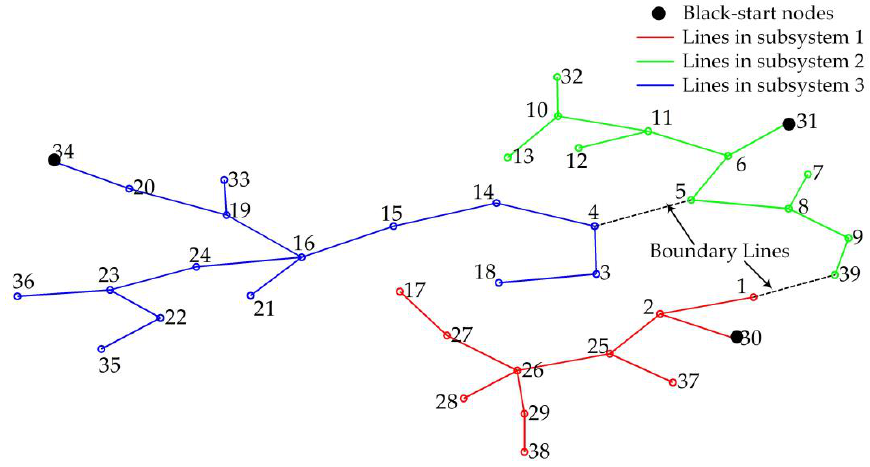
Table 2. The sectionalizing result of IEEE 39-bus test system.